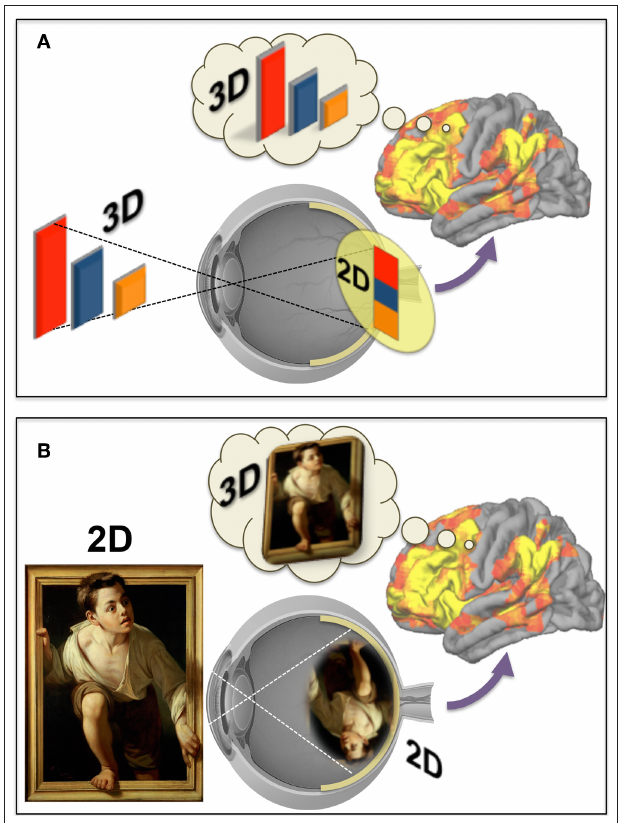
FIGURE 2 | The construction of space. The problem of the brain is to reconstruct 3-D from a flat projection (A) , and the problem of painters is to represent 3-D on a flat surface (B) . The picture is “Escaping from the critic” by Pere Borell (1835–1910), Colección Banco de España,